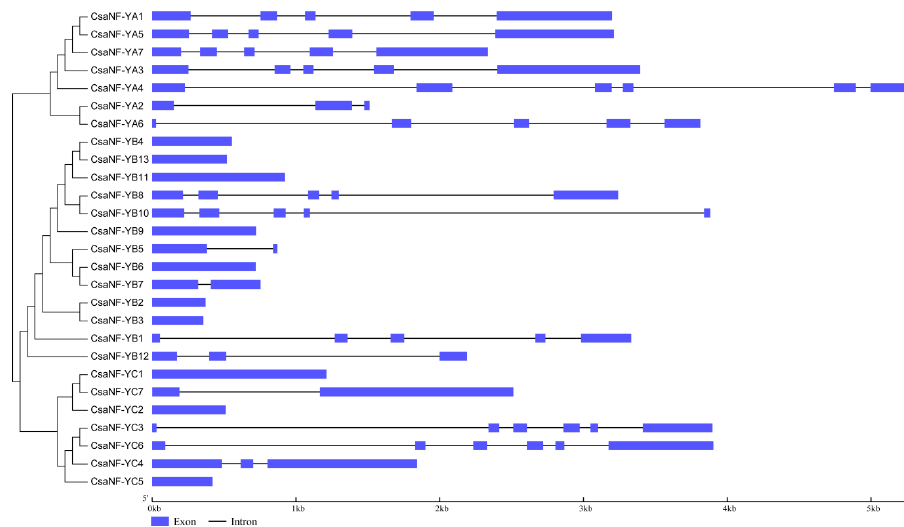
Figure 4. Gene structure analysis of CsaNF-Y genes according to the phylogenetic relationship. The blue boxes and black lines indicate exons and introns, respectively, and their lengths can be estimated by the scale bar at the bottom.